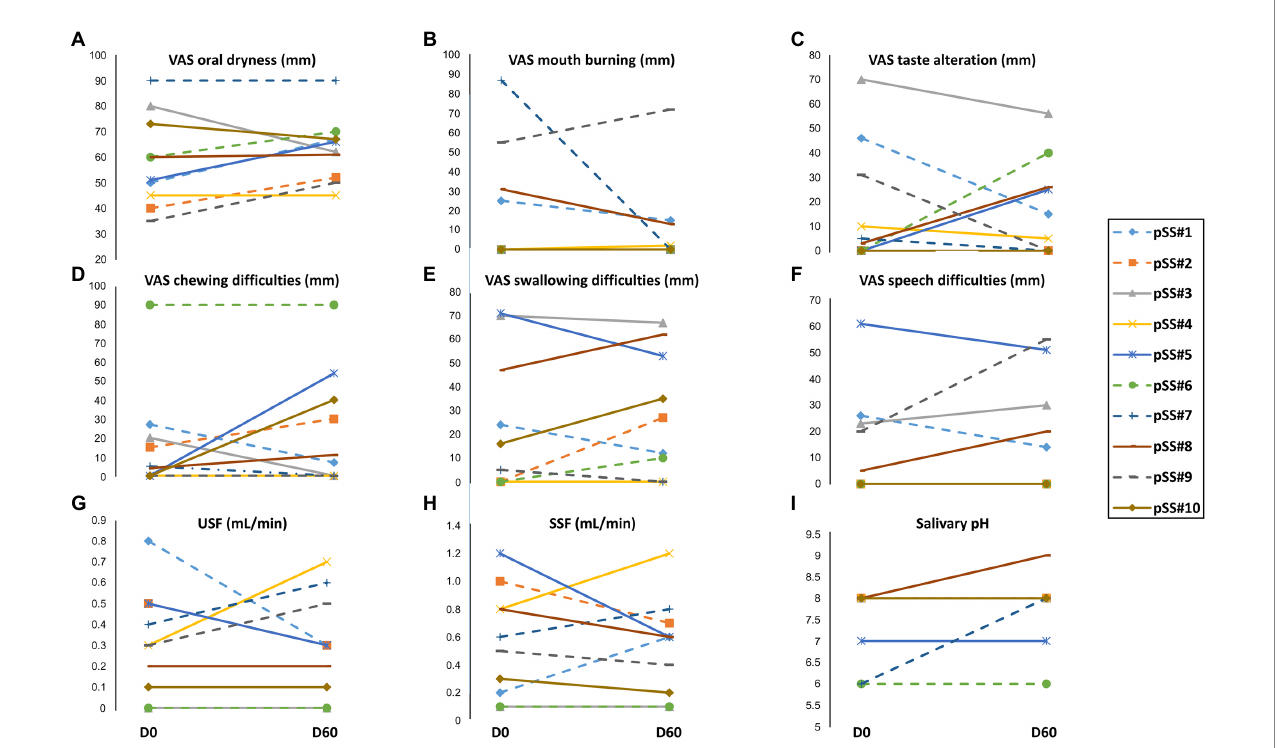
FIGURE 2 Subjective [visual analog scale (VAS) scores] and objective evaluation of oral dryness between baseline D0 and D60 (1 month after wash-out). (A) VAS scores for dry mouth, (B) VAS scores for mouth burning, (C) VAS scores for taste alteration, (D) VAS scores for chewing difficulties, (E) VAS scores for swallowing difficulties, (F) VAS scores for speech difficulties, (G) Unstimulated salivary flow (USF) rate, (H) Stimulated salivary flow (SSF) rate, and (I) Salivary pH.